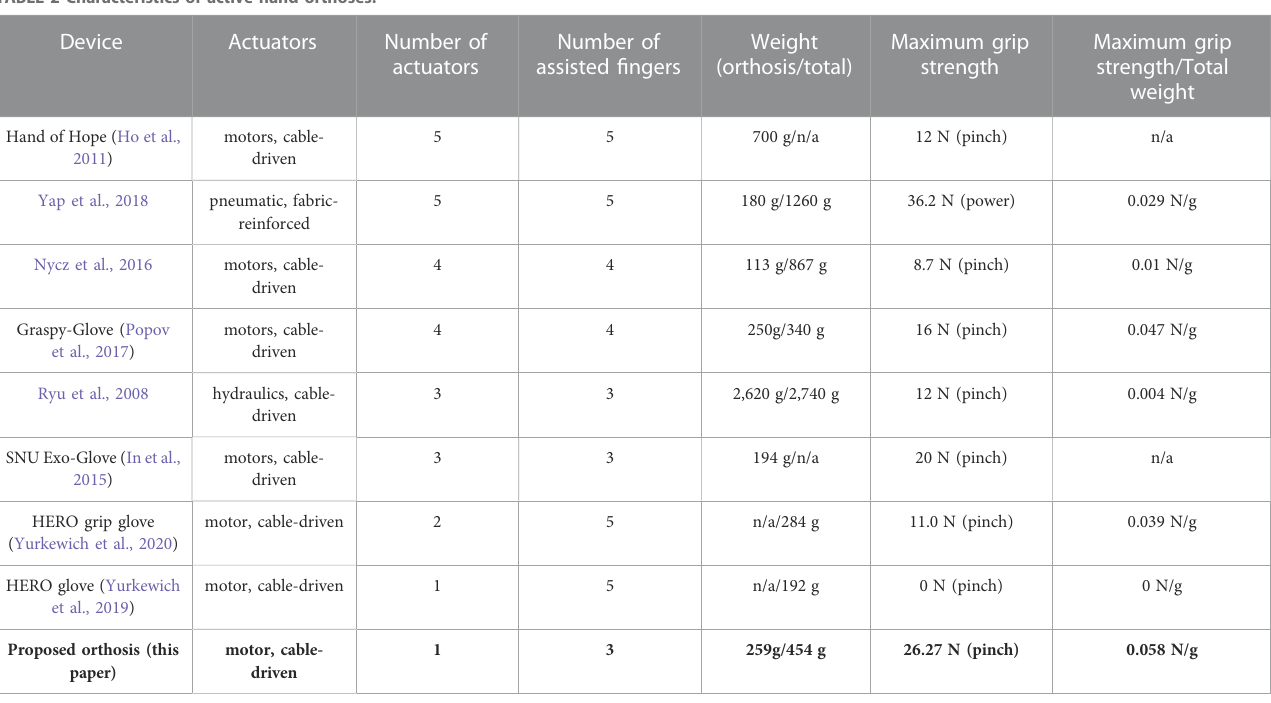
TABLE 2 Characteristics of active hand